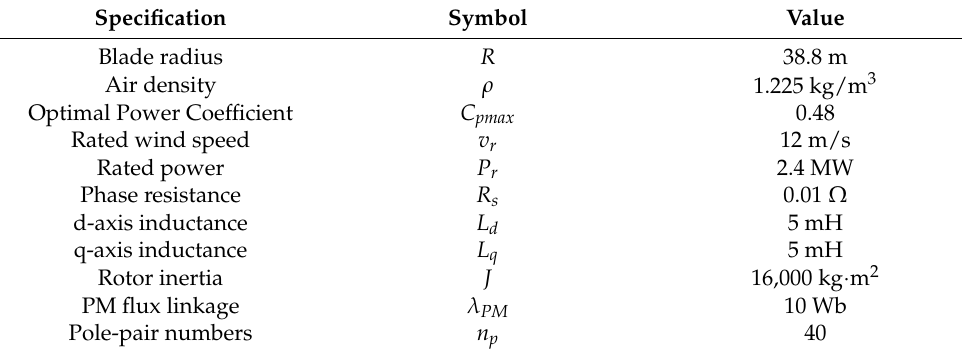
Table 2. Parameters of the PMSG based wind power system.